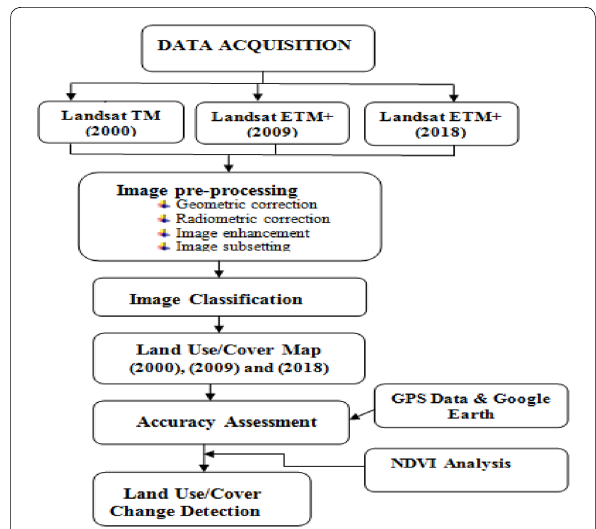
Fig. 2 Flow chart for LULC change analysis process